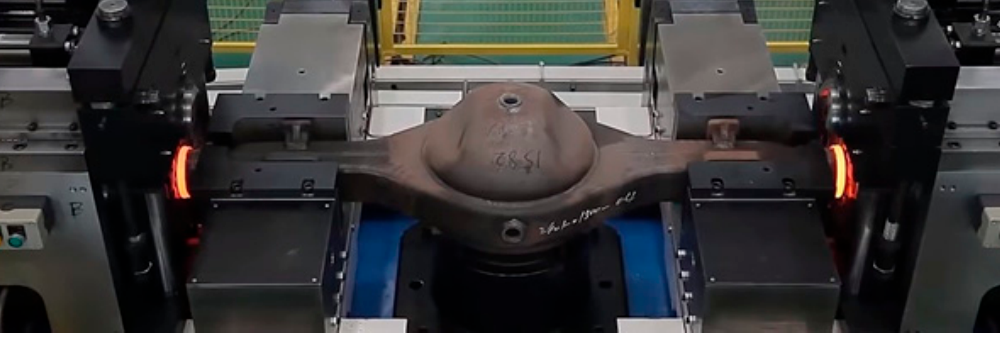
Figure 11. Friction welding of axles (China RCM).